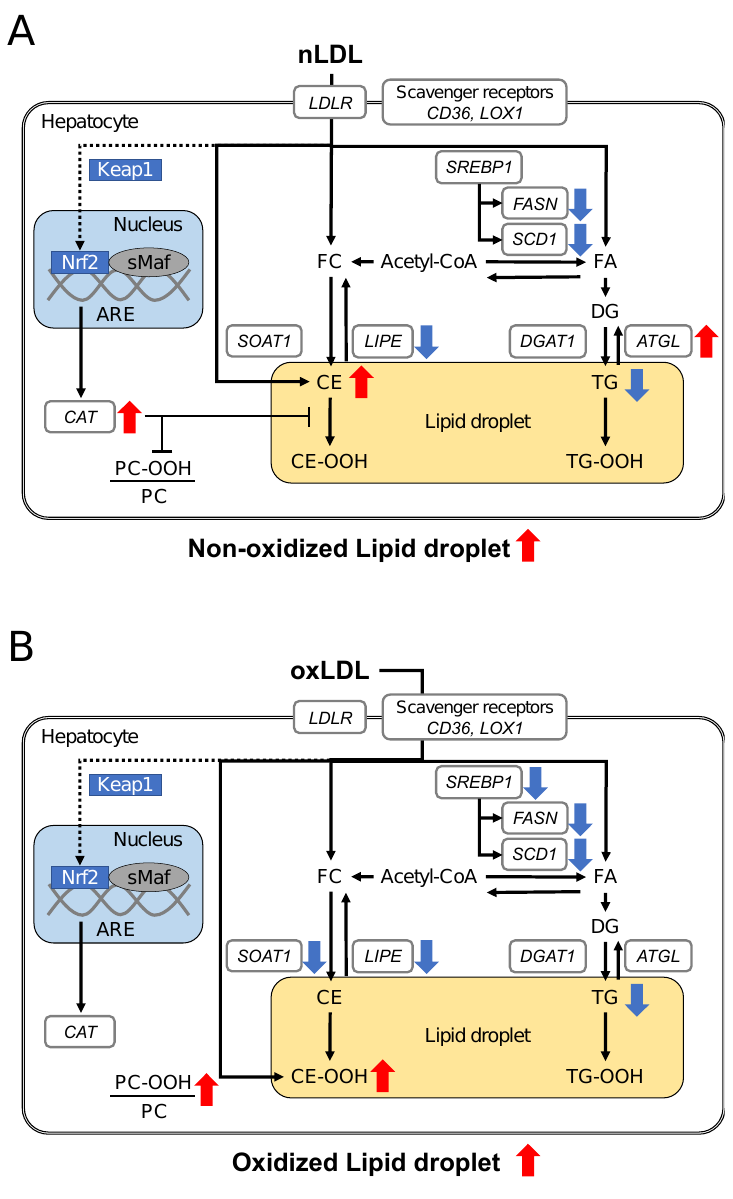
Figure 7. The hypothesized mechanism of lipid metabolism changes in the LDL-supplemented C3A cells. ( A ) Changes in lipid metabolism in the nLDL-supplemented C3A cells. nLDL decreased the expression of genes involved in CE lipolysis ( LIPE ), which may be associated with accumulated CE and increased lipid droplets. nLDL increased the expression of genes involved in fatty acid synthesis ( FASN and SCD1 ) and TG hydrolysis ( ATGL ). Additionally, nLDL decreased some TG molecular species. Moreover, nLDL increased the expression of an antioxidative enzyme, CAT . Taken together, nLDL might exert protective effects on the hepatocytes by increasing TG hydrolysis and antioxidant enzyme expression. ( B ) Changes in lipid metabolism in the oxLDL-supplemented C3A cells. oxLDL caused downregulation of genes involved in CE metabolism ( LIPE and SOAT1 ) and increased lipid hydroperoxide-containing lipid droplets, CE-OOH and PC-OOH/PC. oxLDL also decreased the expression of genes involved in fatty acid synthesis ( SREBP1 , FASN , and SCD1 ) and some